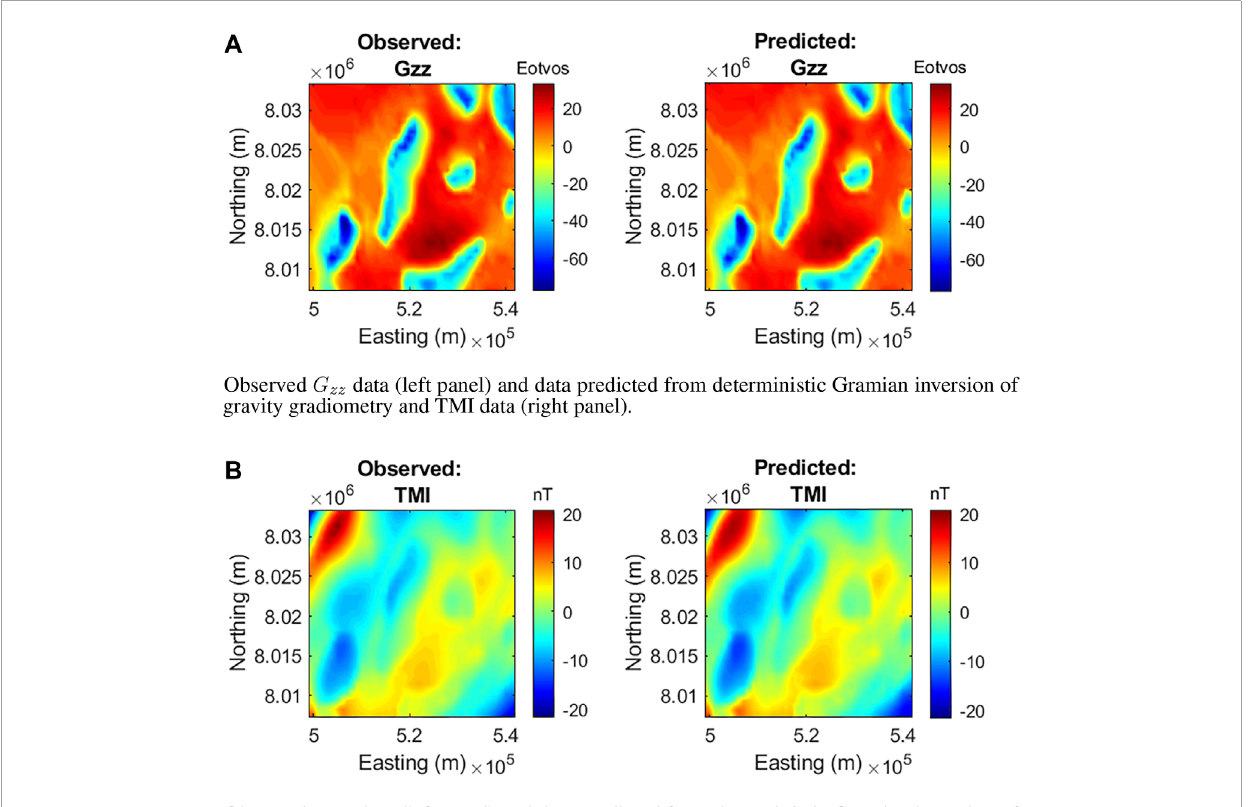
FIGURE 4 Observed and predicted data from deterministic Gramian inversion. (A) Observed G zz data (left panel) and data predicted from deterministic Gramian inversion of gravity gradiometry and TMI data (right panel). (B) Observed TMI data (left panel) and data predicted from deterministic Gramian inversion of gravity gradiometry and TMI data (right